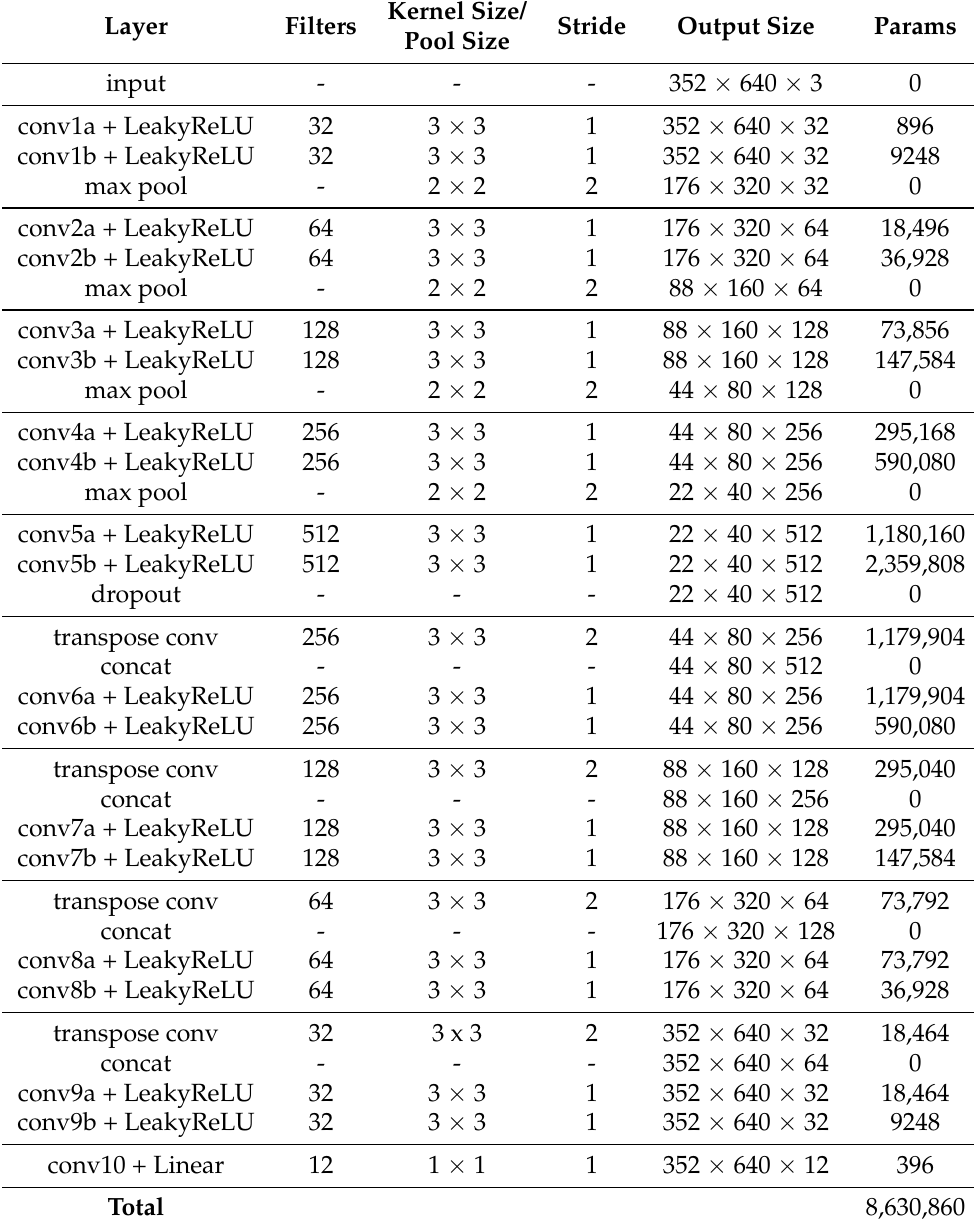
Table 1. The proposed fringe-to-fringe architecture and layer